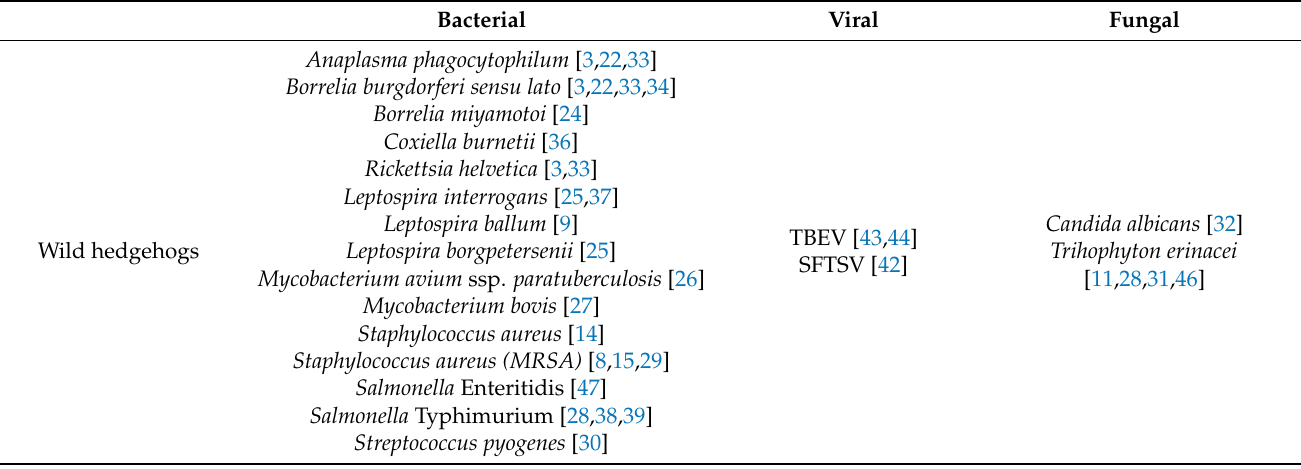
Table 2. Zoonotic pathogens isolated from wild and pet hedgehogs. Bacterial Viral